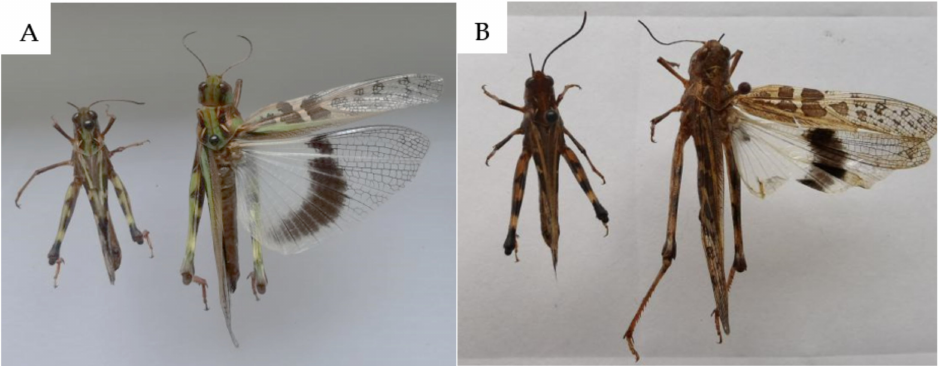
Figure 1. Images of green ( A ) and brown ( B ) Oedaleus decorus asiaticus . In each figure, the left specimen is a male and the one on the right is a